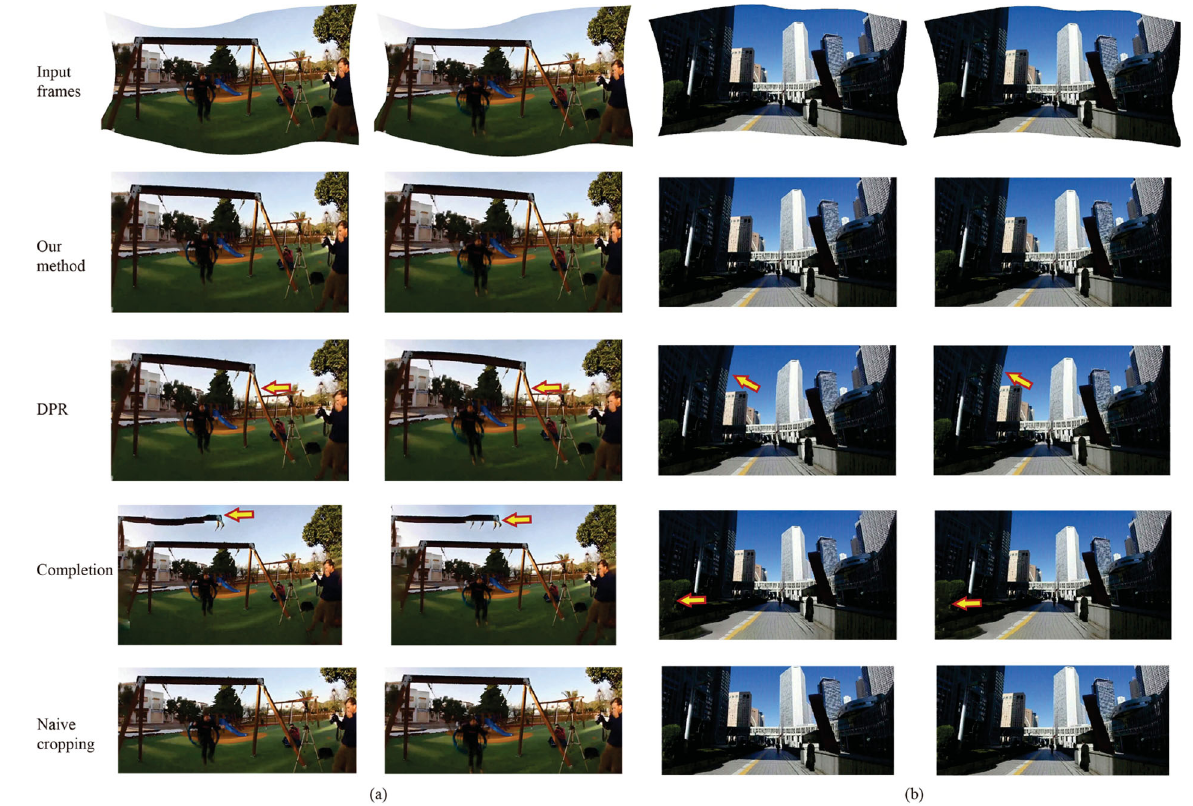
Fig. 6 Comparison of rectangling distortion-corrected fish-eye videos. Top to bottom: input frames of two examples; rectangling results using our approach, DPR [16], a video completion method [12], and naive